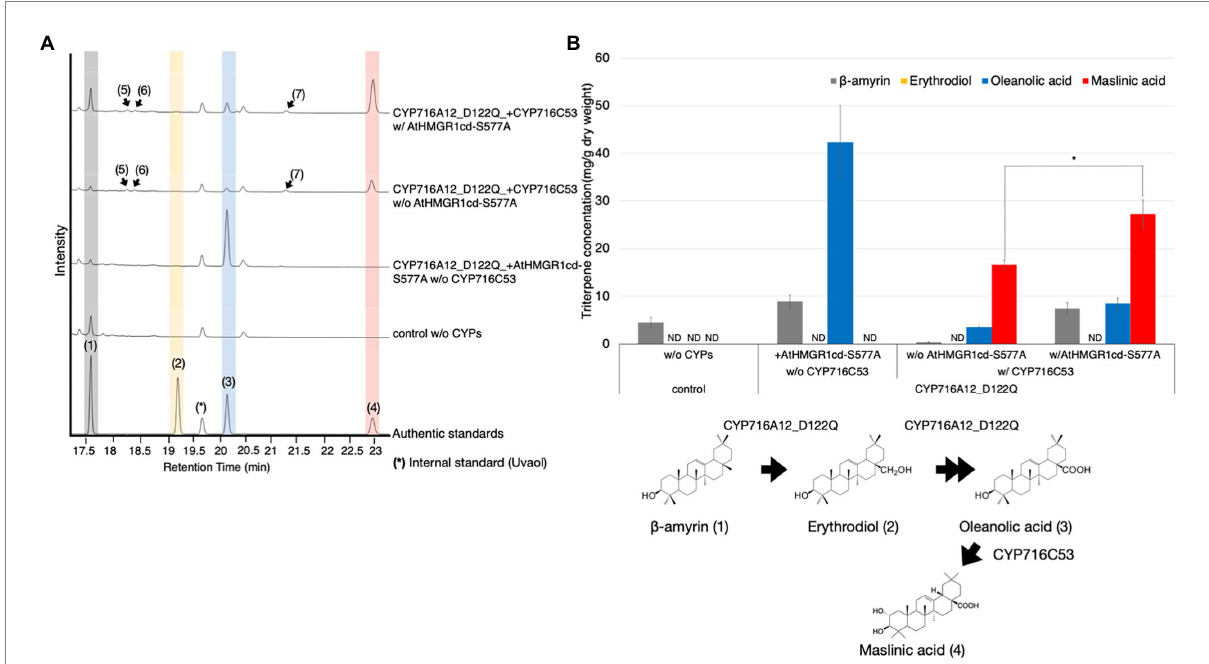
FIGURE 5 Production of maslinic acid in Nicotiana benthamiana leaves using the Tsukuba system. (A) TICs of extracts from N . benthamiana leaves transiently expressing a combination of LjOSC, LjCPR2, CYP716A12_D122Q, and CYP716C53 with or without AtHMGR1cd-S577A. A combination of pBYR2HS expressing LjOSC, LjCPR2, and empty vector was used as a background control. β -Amyrin ( 1 ), erythrodiol ( 2 ), oleanolic acid ( 3 ), and maslinic acid ( 4 ) were used as authentic standards. Uvaol (*) was used as an internal standard. (B) Quantification of maslinic acid concentration in N . benthamiana leaf extract. Data are representative of at least three biological replicates ( n = 3) and are expressed as the mean ± SEM. Differences in maslinic acid concentration were compared using Student’s t -test for each sample. * p < 0.05; ND, not